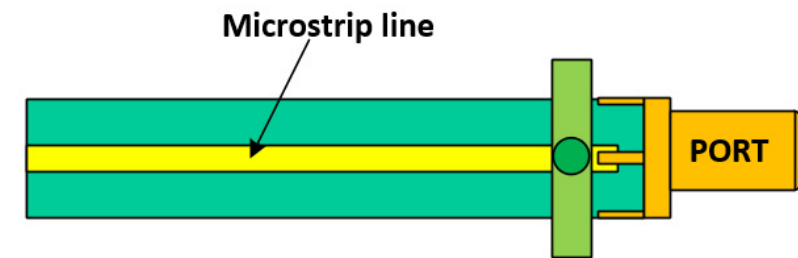
Figure 28. The picture of the SIW resonators.